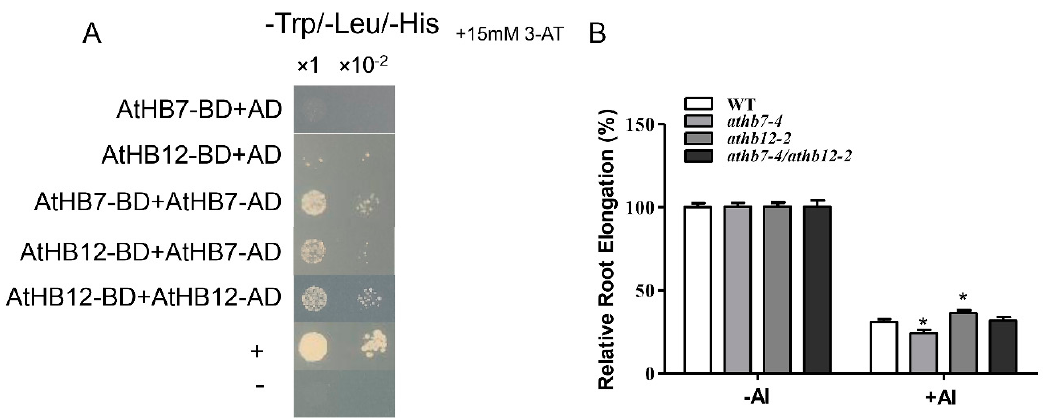
Figure 7. AtHB7 and AtHB12 might act in homodimer or heterodimer in response to Al stress. ( A ) AtHB7 and AtHB12 could form homodimer and heterodimer showed by yeast two-hybrid assay. ( B ) Relative root growth of wild type, athb7 , athb12 and athb7/athb12 double mutant in response to Al treatment. Data are means ± SD ( n = 30). Asterisks indicate significant differences between wild type treatment. Data are means ± SD ( n = 30). Asterisks indicate significant di ff erences between wild type and mutants at *: p < 0.05 by Tukey’s test. and mutants at *: p < 0.05 by Tukey’s